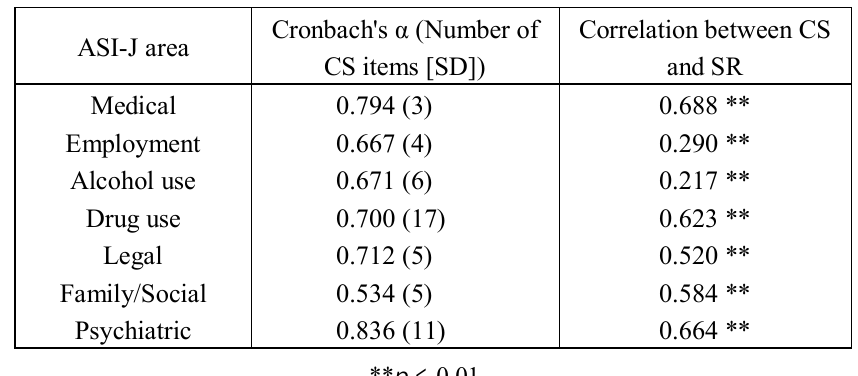
Table 5. Internal consistency of CSs in each ASI-J area and correlations between CSs and SRs in alcohol-dependent individuals ( n = 321).